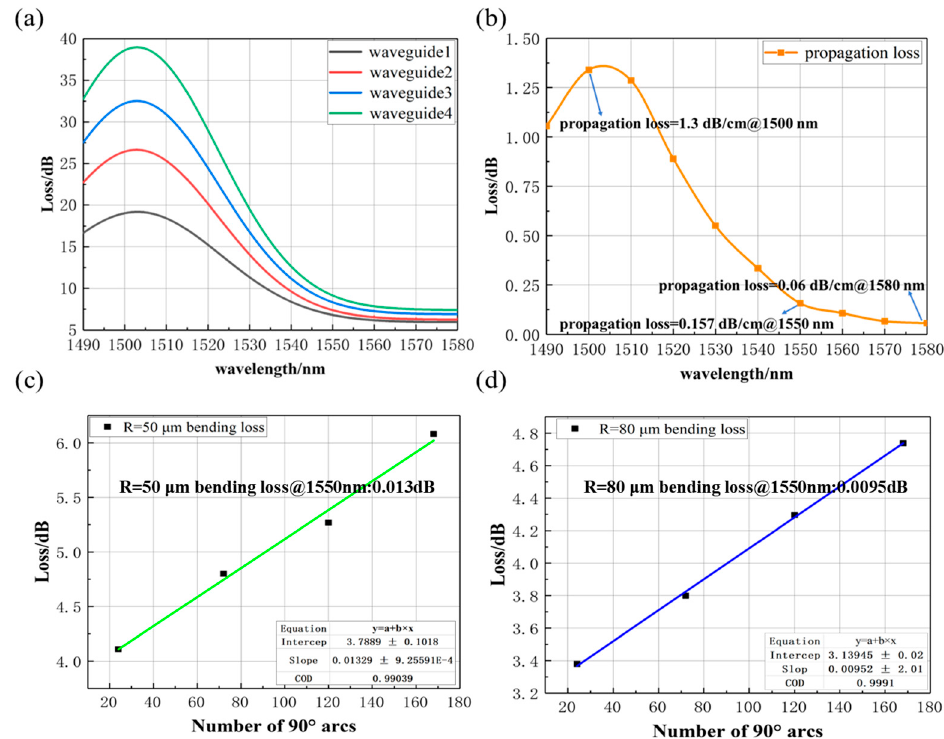
Figure 13. The measurement result of the Si 3 N 4 waveguide with a cross-sectional size of 0.4 µm × 1 µm ( a ) the transmission loss of the cutback structure in the wavelength range of 1490–1580 nm, ( b ) the fi tt ed propagation loss in the wavelength range of 1490–1580 nm, ( c ) the fi tt ing line of bending loss @1550 nm per 90° bending waveguide for a radius of 50 µm, ( d ) the fi tt ing line of bending loss @1550 nm per 90° bending waveguide for a radius of 80 µm. Table 4. Summary of propagation losses at 1550 nm for Si 3 N 4